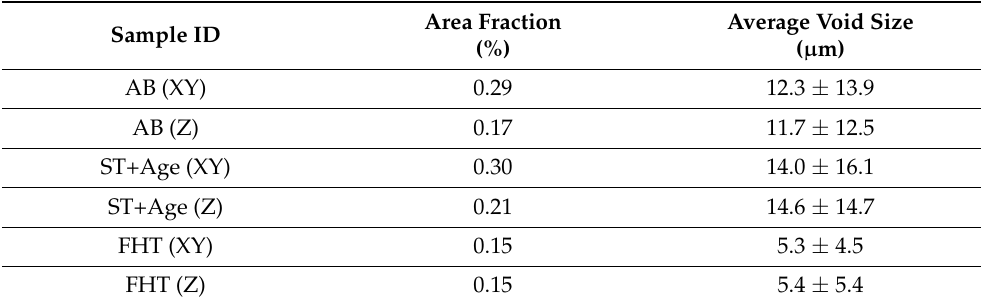
Table 4. Summary of void analysis.